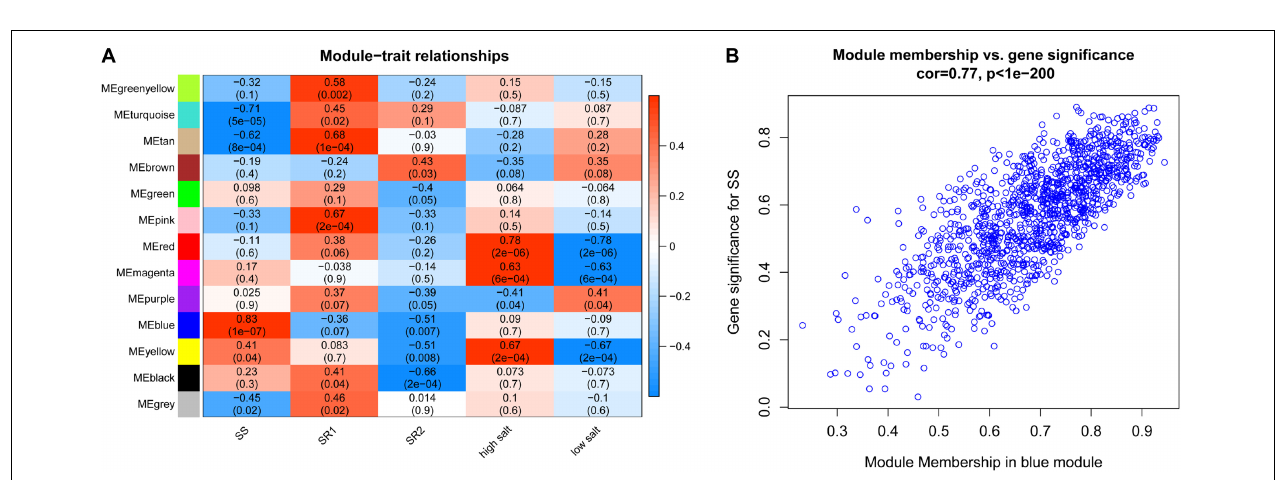
FIGURE 2 | (A) Heatmap of the module–trait relationship: red for positive correlation and blue for negative correlation. (B) Scatter diagrams of genes in the blue module. The x -axis represents gene significance, and the y -axis represents module membership.